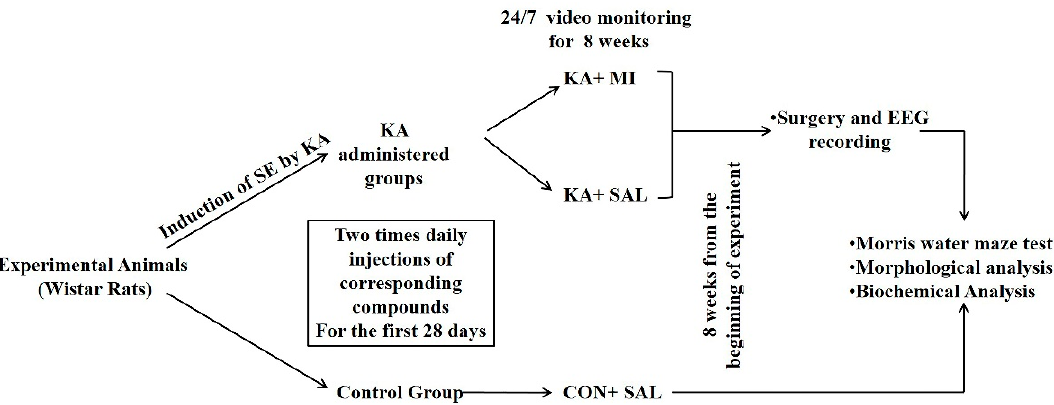
Figure 8. Schematic representation of the experimental design (see detailed description in the text).